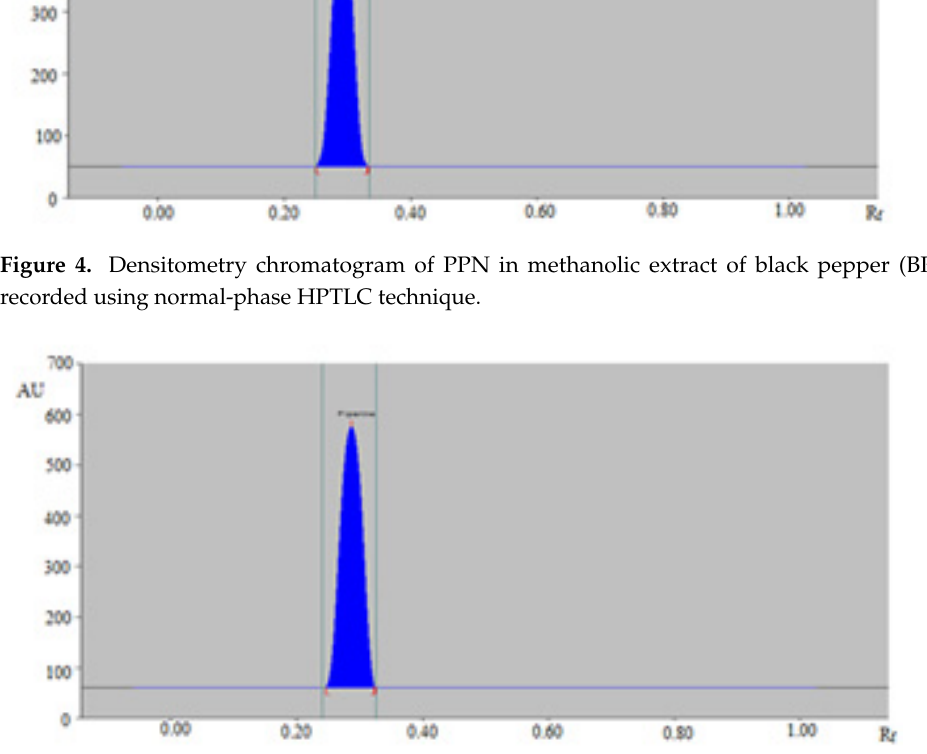
Figure 4. Densitometry chromatogram of PPN in methanolic extract of black pepper (BPMH) rec- orded using normal-phase HPTLC technique.